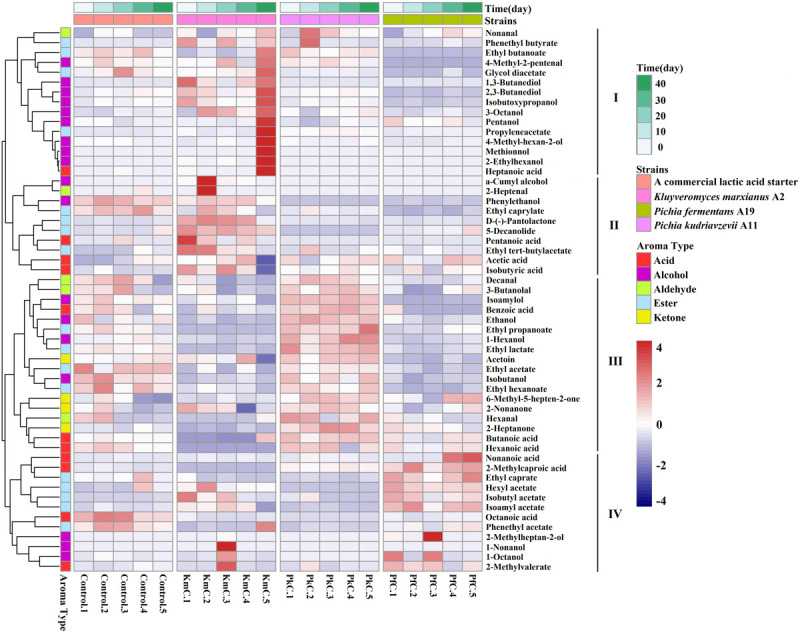
Correlation analysis between five fermentation periods of strains. The letters control, KmC, PkC, and PfC represent cheeses fermented by a commercial lactic acid starter, a commercial lactic acid starter with K. marxianus A2, P. fermentans A19, and P. Kudriavzevii A11, respectively. 1–5 represent 0, 10, 20, 30, and 40 days of fermentation time.